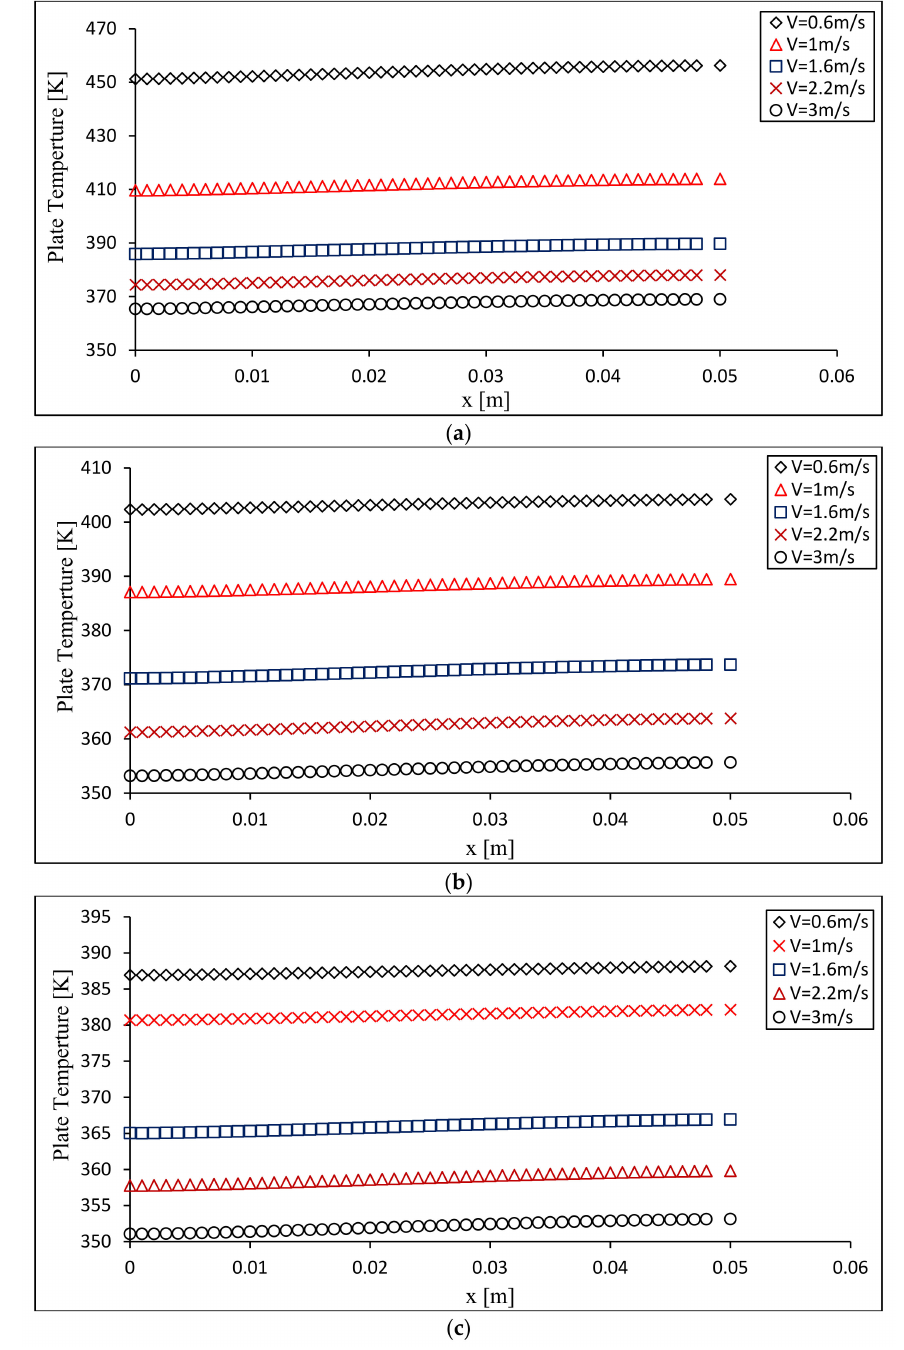
Figure 2. Local wall temperature at various inlet air speeds for 40 ppi foam having porosity: ( a ) 90%, ( b ) 70%, and ( c )